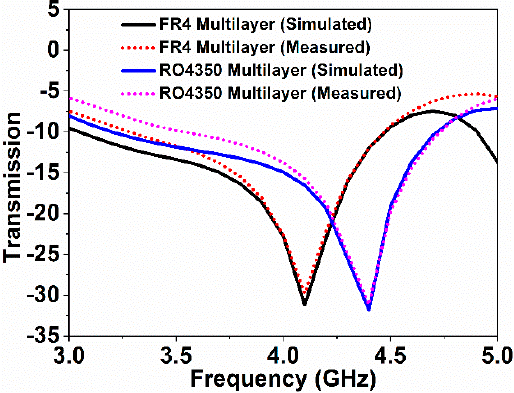
Figure 11. Transmission variances with FR4 and Rogers RO4350 multiple over-layers.